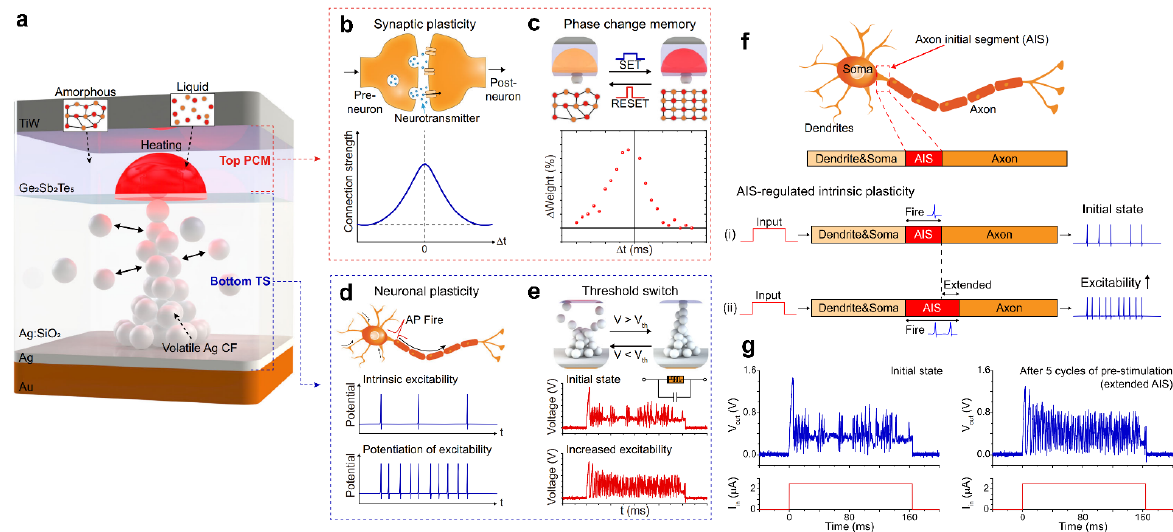
Figure 4. Structure-designed memristor with simultaneous neuronal and synaptic function in a single device. ( a ) Schematic of an integrated phase-change memory (PCM) and Ag filamentary memristor. ( b ) Biological synaptic plasticity and ( c ) corresponding synaptic plasticity of the PCM layer. ( d ) Biological neuron and its excitability based on intrinsic plasticity. ( e ) Corresponding volatile Ag filamentary threshold switching (TS) memristor showing similar excitability (right). ( f ) Intrinsic plasticity of biological neuron based on axon initial segment (AIS) length. ( g ) Excited signal output of TS layer indicating emulated intrinsic plasticity; adapted with permission from ref. [64], copyright 2022 Springer Nature.